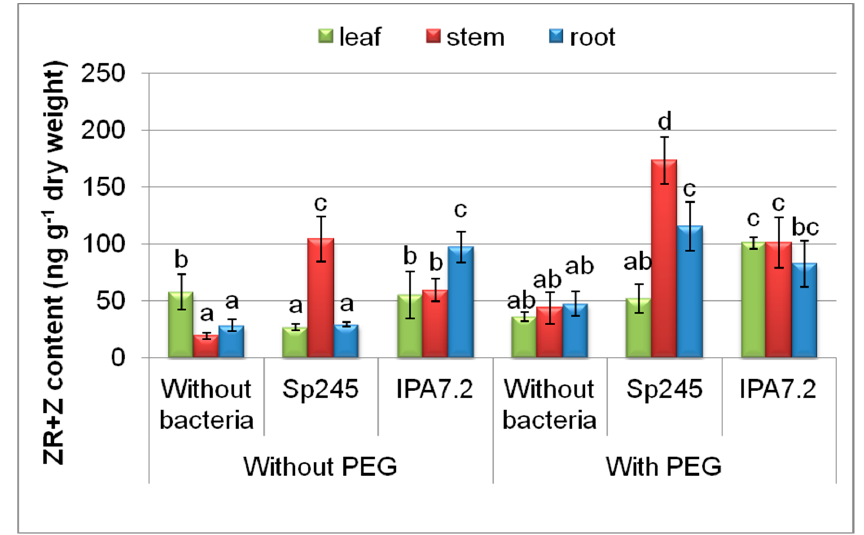
Figure 3. The effect of PEG and microplants’ inoculation with bacterial strains ( A. brasilense Sp245 and O. cytisi IPA7.2) on the content of zeatin derivatives (ZR+Z) in organs of potato plants cultivated